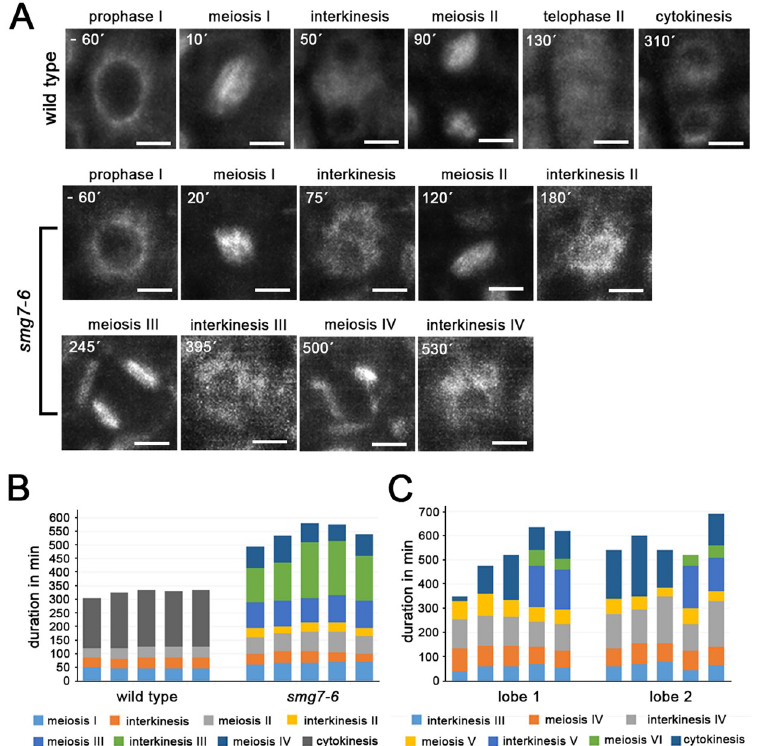
Fig 3. Live imaging of meiotic progression in smg7-6 PMCs. (A) Time-lapse series of PMCs containing microtubules labeled with the p RPS5A :: TagRFP : TUB4 construct. Timepoints relate to nuclear envelope breakdown at the end of prophase I. Scale bars correspond to 5 μ m. (B) Duration of indicated meiotic stages inferred from spindle dynamics in time-lapse movies of p RPS5A :: TagRFP : TUB4 .Five individual PMCs from each wild type and smg7-6 plants are shown. (C) Duration of postmeiotic cycles of spindle assembly and disassembly in individual PMCs from two separate anther lobes of smg7-6 mutants.